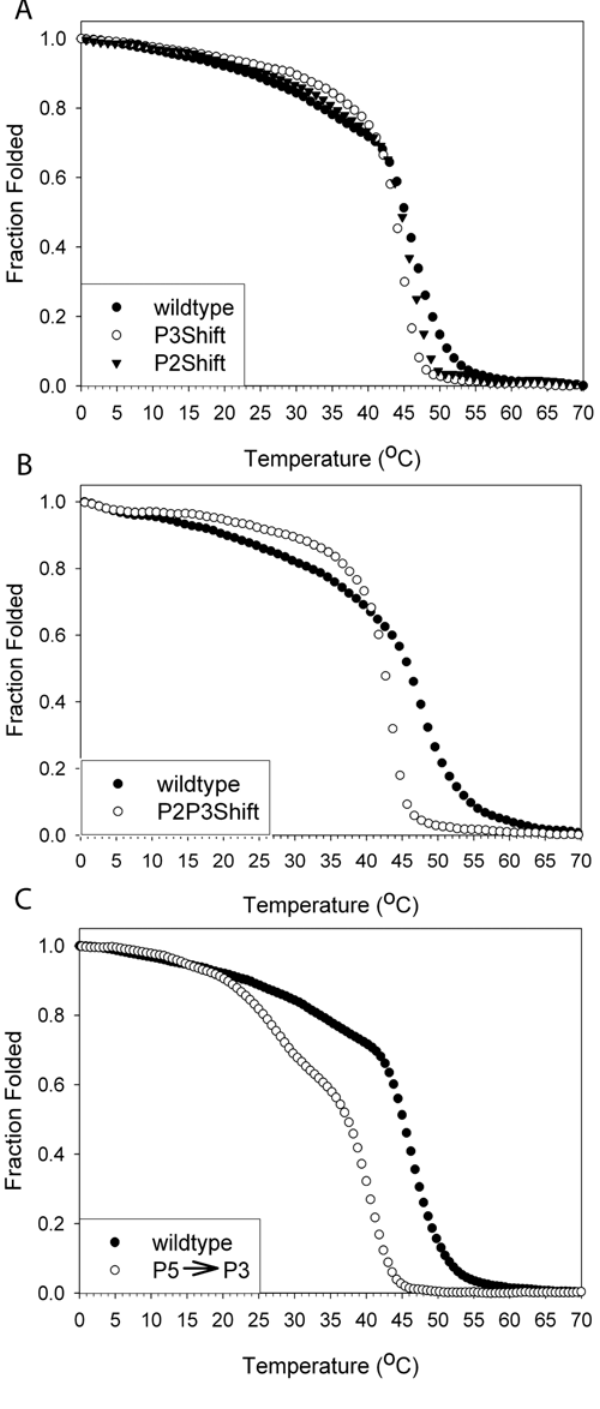
Figure 2. The effect on the thermal stability of the cluster and period replacement mutants. Fraction folded as measured by relative ellipticity at 222 nm as a function of temperature in 500 mM NaCl, 10 mM sodium phosphate pH 7.5, 1 mM EDTA, 0.5 mM DTT. The tropomyosin concentration was 0.01 mg/ml (1.6 m M). The T M s are reported in Tables 2 and 3. The fraction folded is relative to the mean N N residue ellipticity at 0 u C where the proteins were fully folded. A. N , wildtype; # , P3Shift, . , P2Shift. B. Symbols: , wildtype; # , Symbols: , wildtype; # , P5 R P3. P2P3Shift. C. Symbols: